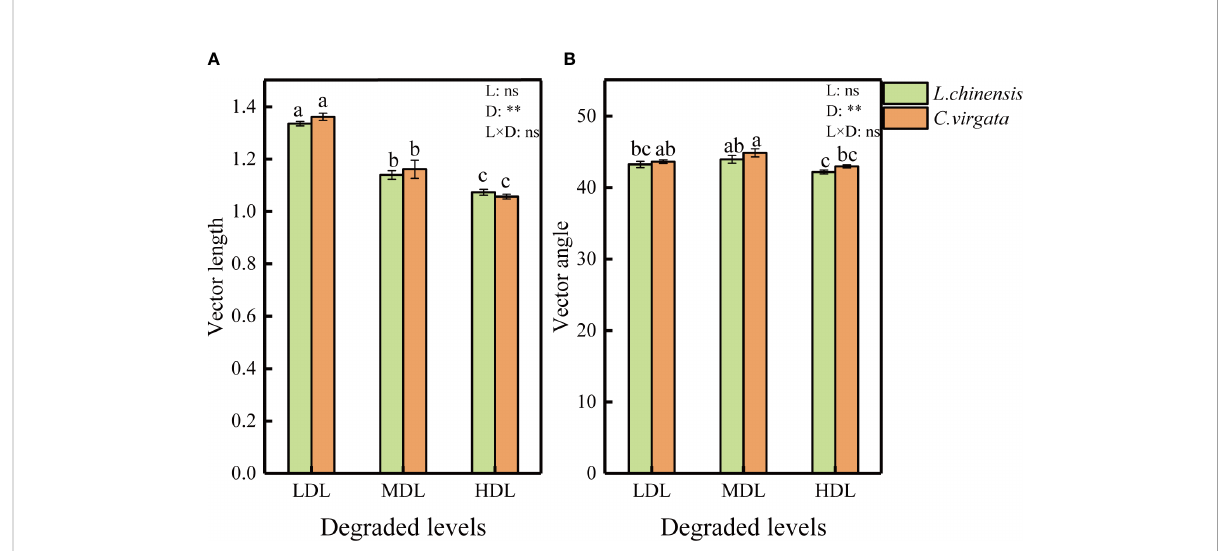
FIGURE 2 Vector length and angle under in fl uence of different litter types at different degraded levels. (LDL, lightly degraded level; MDL, moderately degraded level; HDL, highly degraded level; L. chinensis , Leymus chinensis ; C. virgata , Chloris virgata . (A) Vector length; (B) Vector angle. Different letters represent signi fi cant differences among means at P <